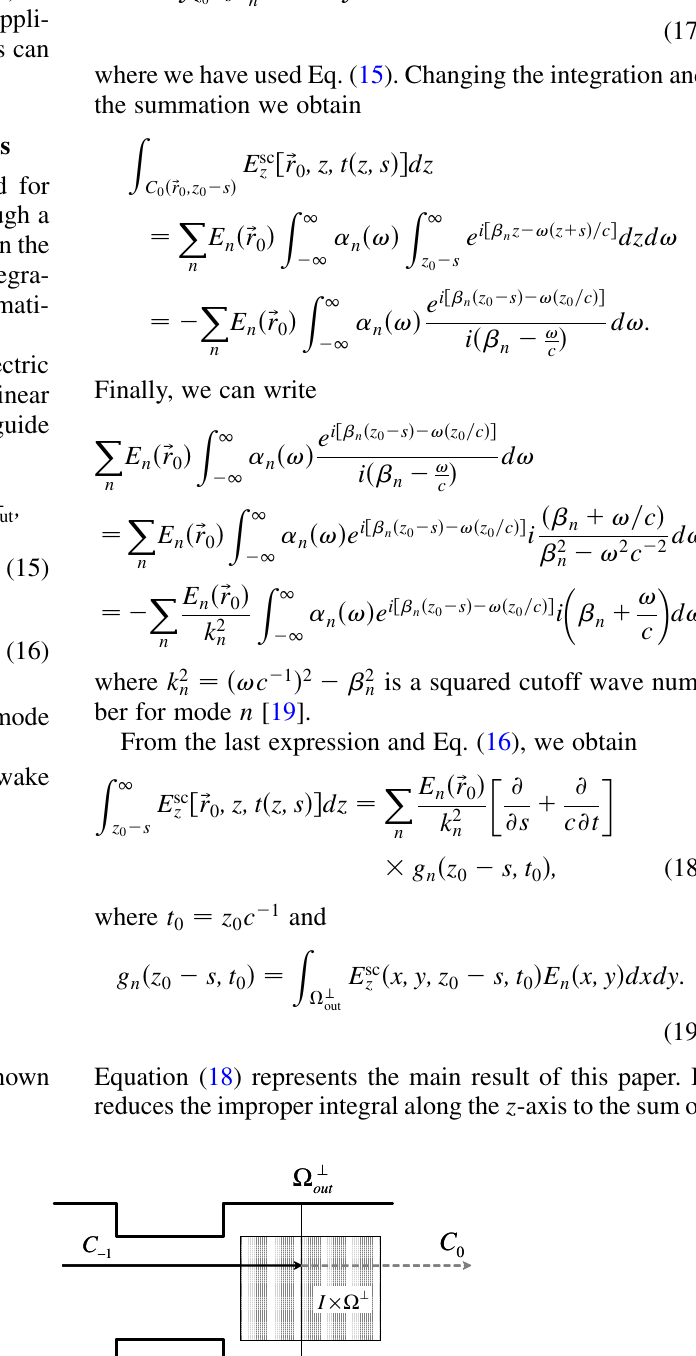
FIG. 5. The rectangular collimator. Contour C (cid:4)